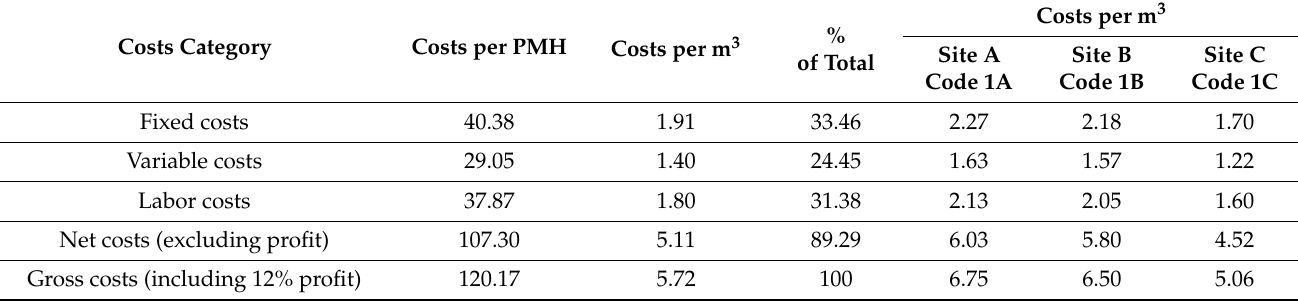
Table 7. Yarding costs ( € ) at the corridor